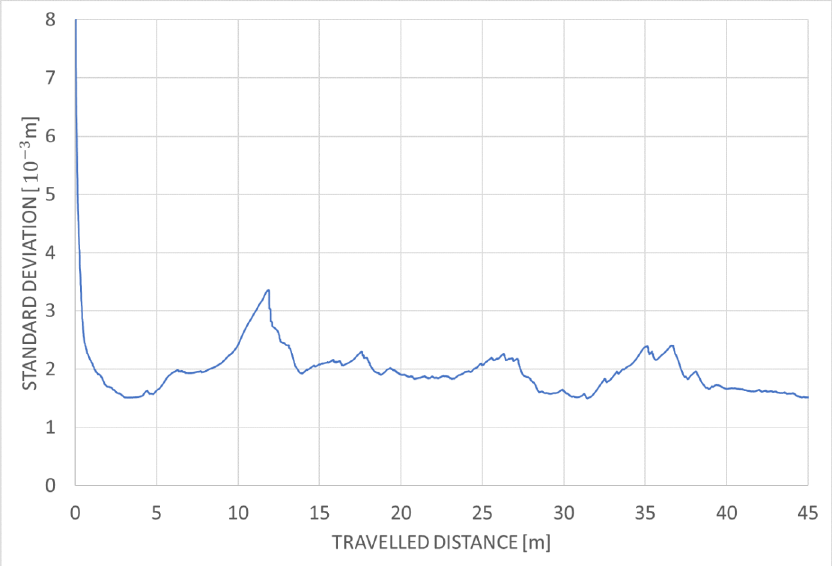
Figure 14. Standard deviation in function of travelled distance for parallel-serial algorithm and cave test